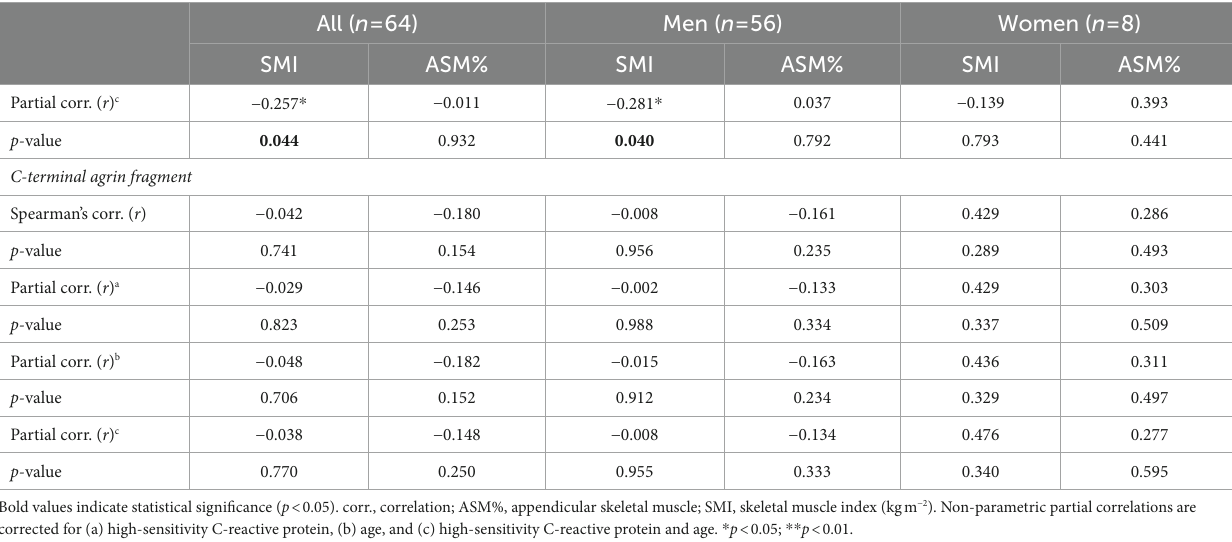
strong, positive association ( r = 0.58) between transthyretin levels and SMI was previously reported in people at a geriatric outpatient hospital (51). Around 40% of people in the study by Sergi et al. (51) were underweight (BMI <20 kg m −2 ). Poorer nutritional status likely